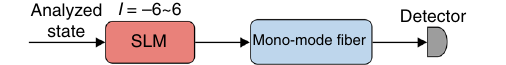
Fig. 7 The scheme of orbital angular momentum mode analysis. SLM spatial light